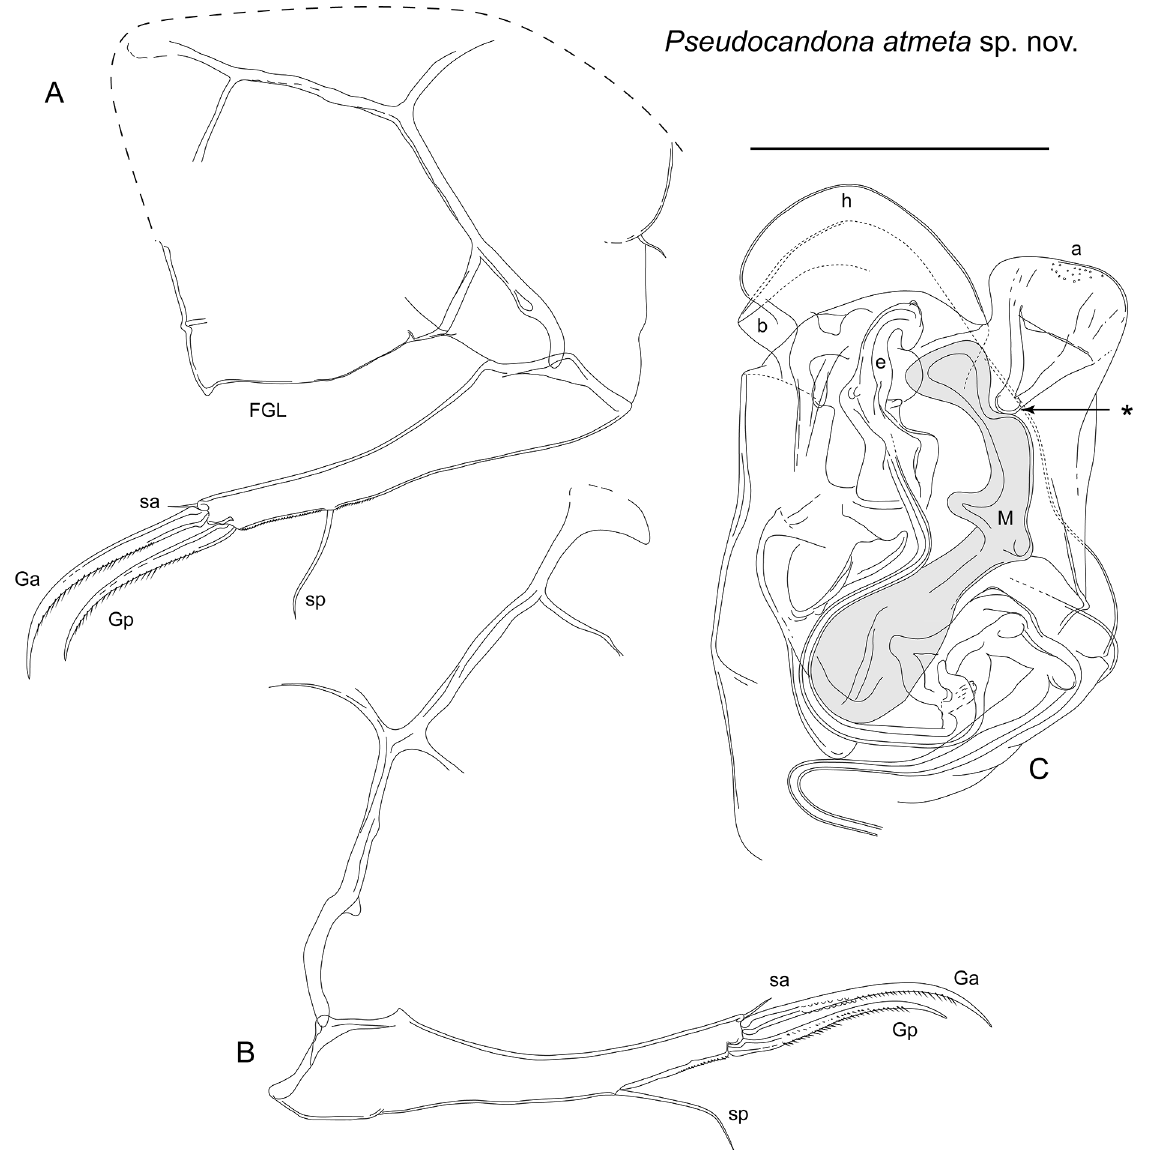
Fig. 10. Pseudocandona atmeta sp. nov. A . Female caudal ramus and genital lobe (LBM 1430006271) (FGL = female genital lobe). B . Male caudal ramus (LBM 1430006270). C . Hemipenis (M-process shaded grey) (LBM 1430006270), asterisk marks protuberance of outer lobe (a) that contacts M-process. Scale bar = 200